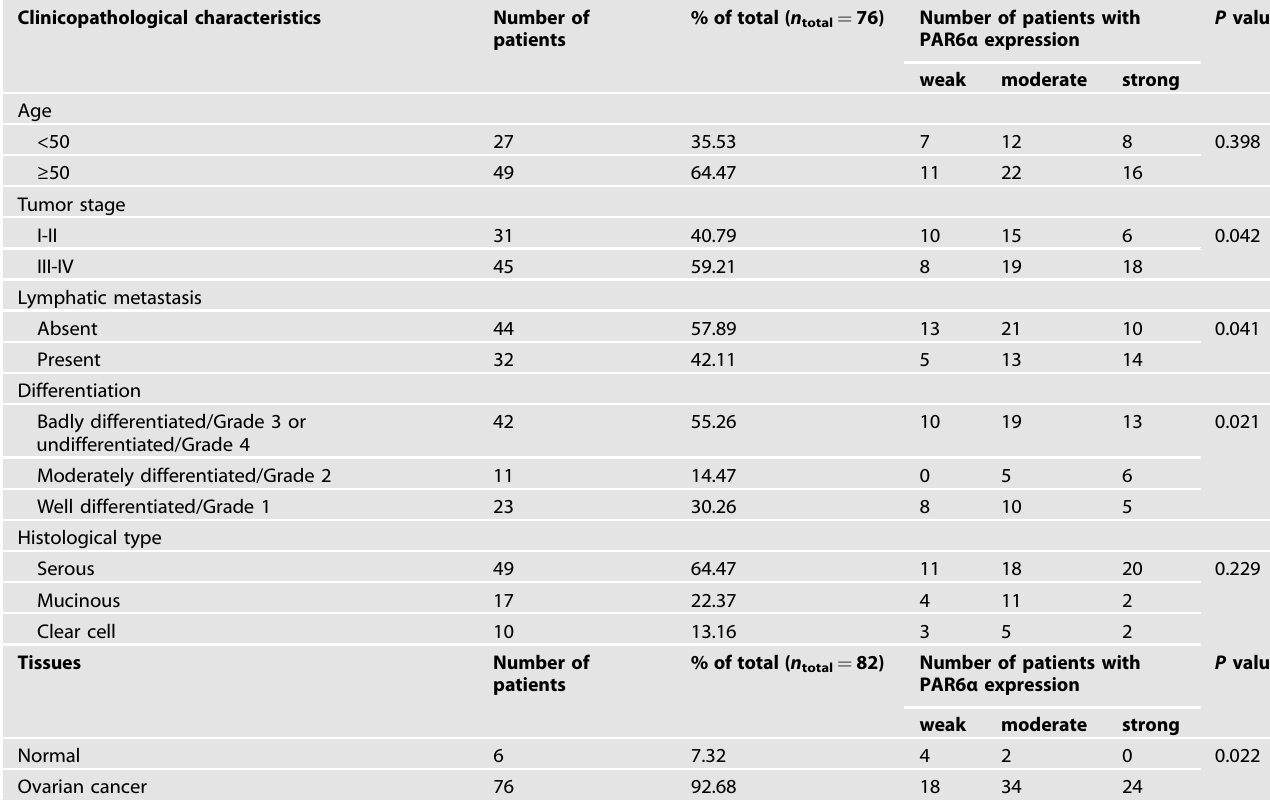
Table 1. Clinical and pathological characteristics of patients with ovarian cancers in the current study. Clinicopathological